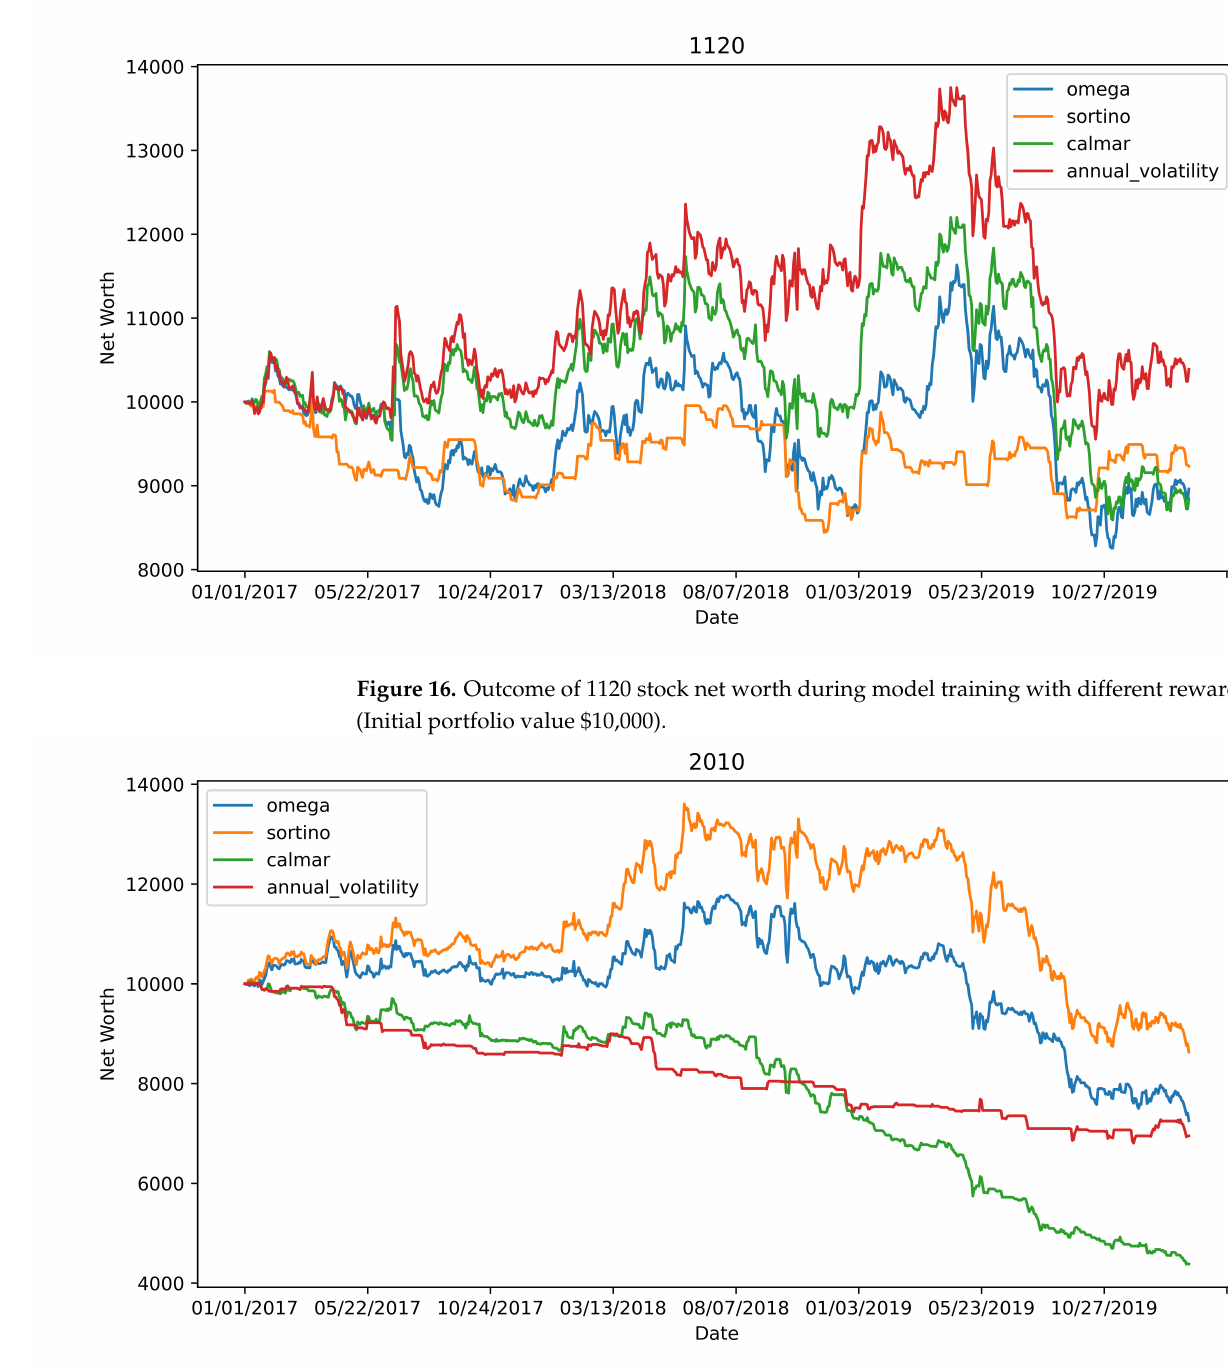
Figure 17. Outcome of 2010 stock net worth during model training with different reward functions (Initial portfolio value